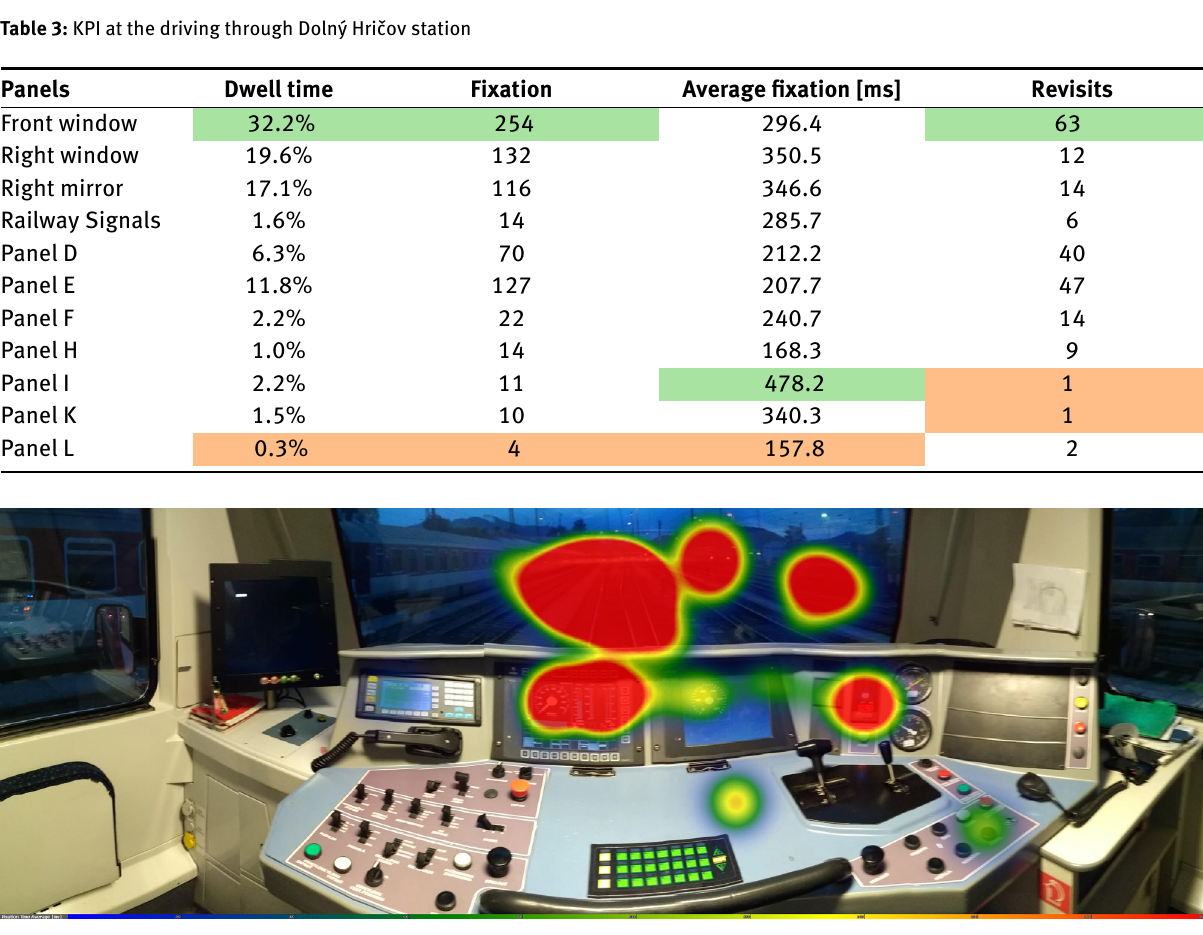
Figure 6: Heatmap of the train driver attention at the section Žilina - Horný Hričov (example 1)